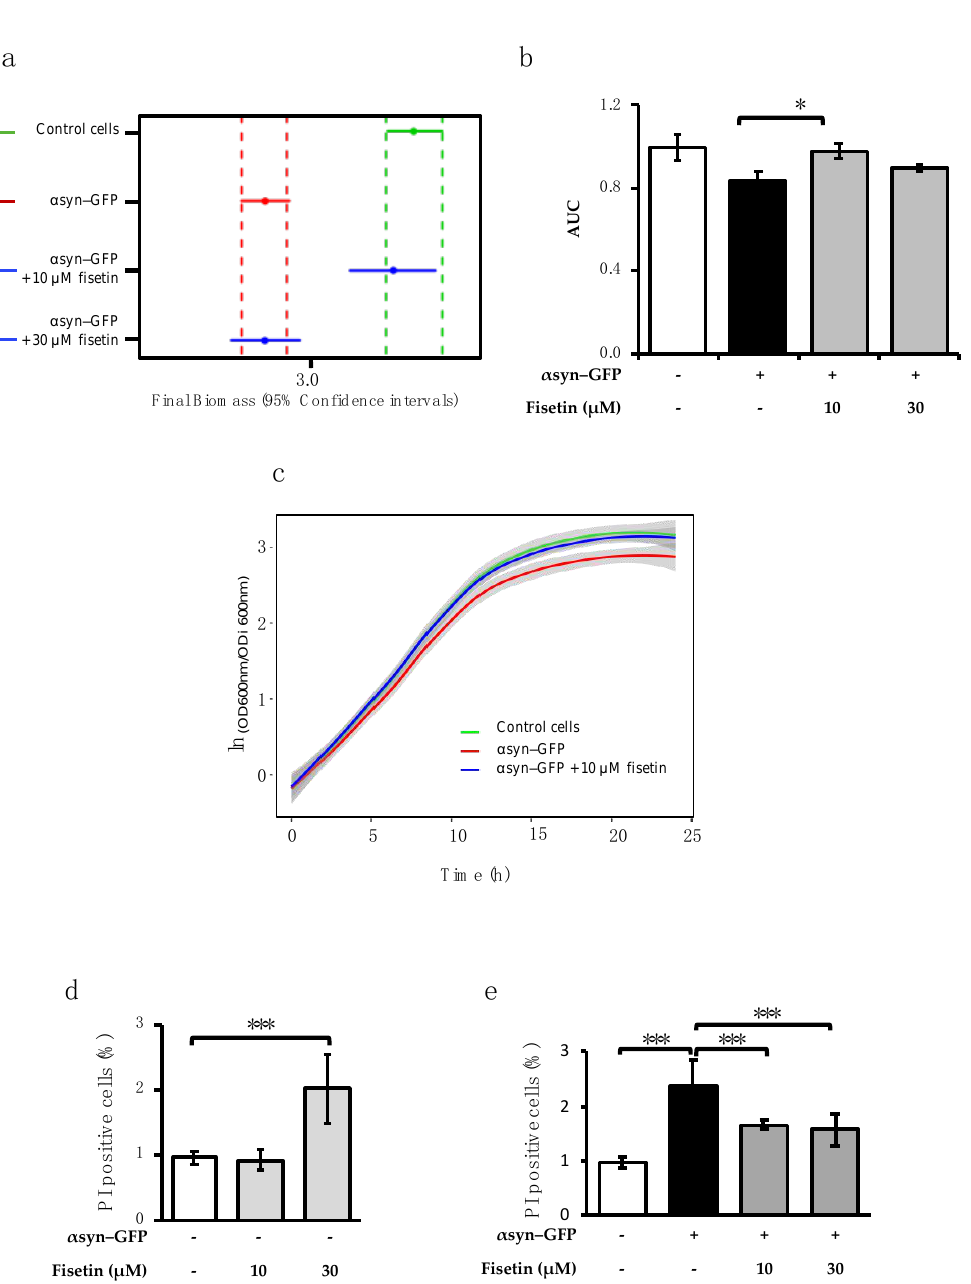
Figure 2. Fisetin protects against α syn-induced growth impairment and toxicity. Control cells and cells expressing α syn– GFP were pre-grown in raffinose medium until mid-log phase. The medium was discarded, and cells were incubated in galactose medium ( α syn ON) supplemented or not with fisetin for 24 h at 30 ◦ C. OD 600 nm was monitored hourly. ( a ) Final biomass 95% confidence intervals were obtained by data modulation using nonlinear parametric regressions and were estimated from the best fit model using RStudio. The vertical dashed line represents the limits of the 95% confidence intervals. ( b ) The area under the curve (AUC) was integrated using the Origin software (OriginLab, Northampton, MA, USA). ( c ) Growth curve of control cells, α syn–GFP-overexpressing cells, and α syn–GFP-overexpressing cells incubated with the protective concentration of fisetin (10 µ M), of which a representative image of the three biological replicates is shown. ( d ) Flow cytometry analysis of yeast cells incubated with propidium iodide to stain dead cells. Control cells incubated with 10 and 30 µ M of fisetin and ( e ) cells overexpressing α syn–GFP incubated with 10 and 30 µ M of fisetin compared with control cells. The values represent the mean ± SEM of at least three biological replicates. Statistic differences are denoted by * p < 0.05 and *** p < 0.01 vs. indicated